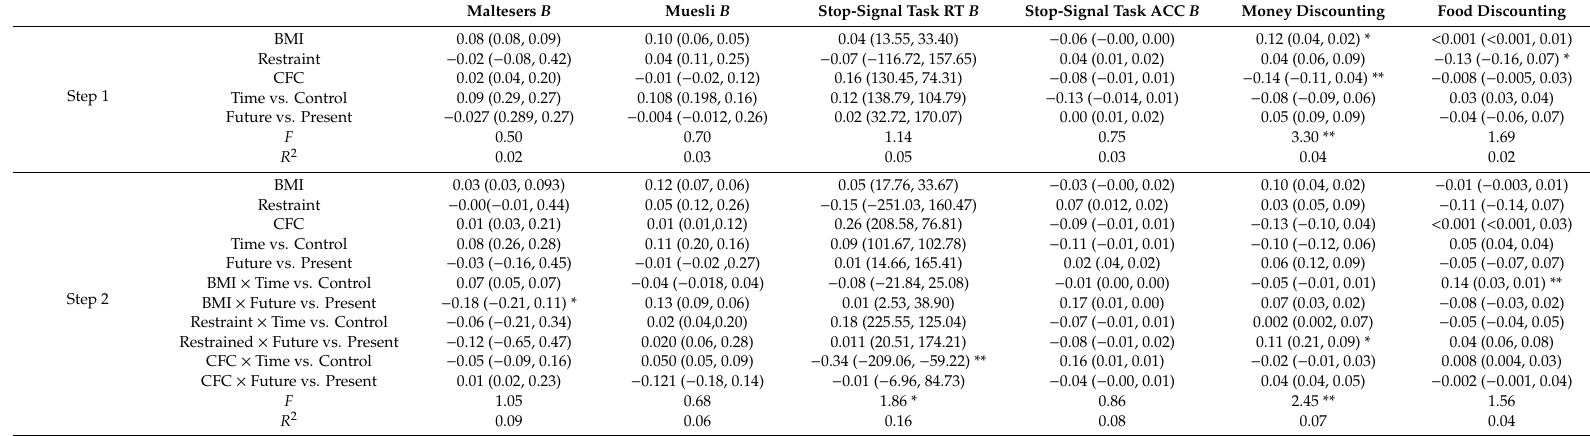
Table 5. Standardized regression coe ffi cients in Experiment 2 for amount of Maltesers and muesli consumed (unstandardized coe ffi cients, standard error in